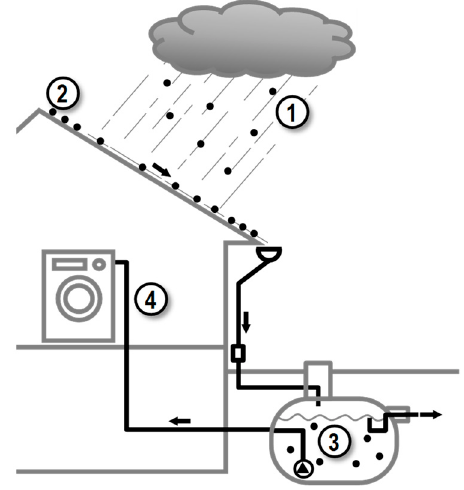
Figure 3. Schematic representation of rainwater harvesting for washing.